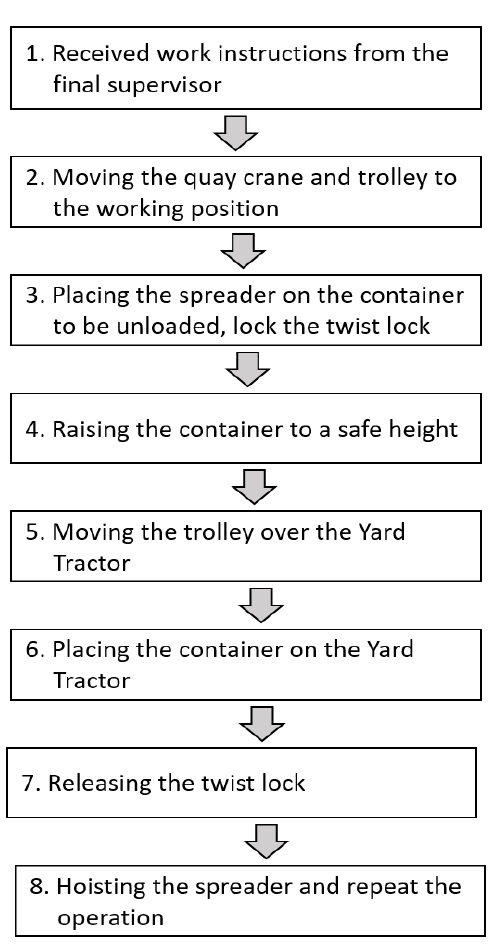
Figure 1. Workflow diagram for the port terminal.